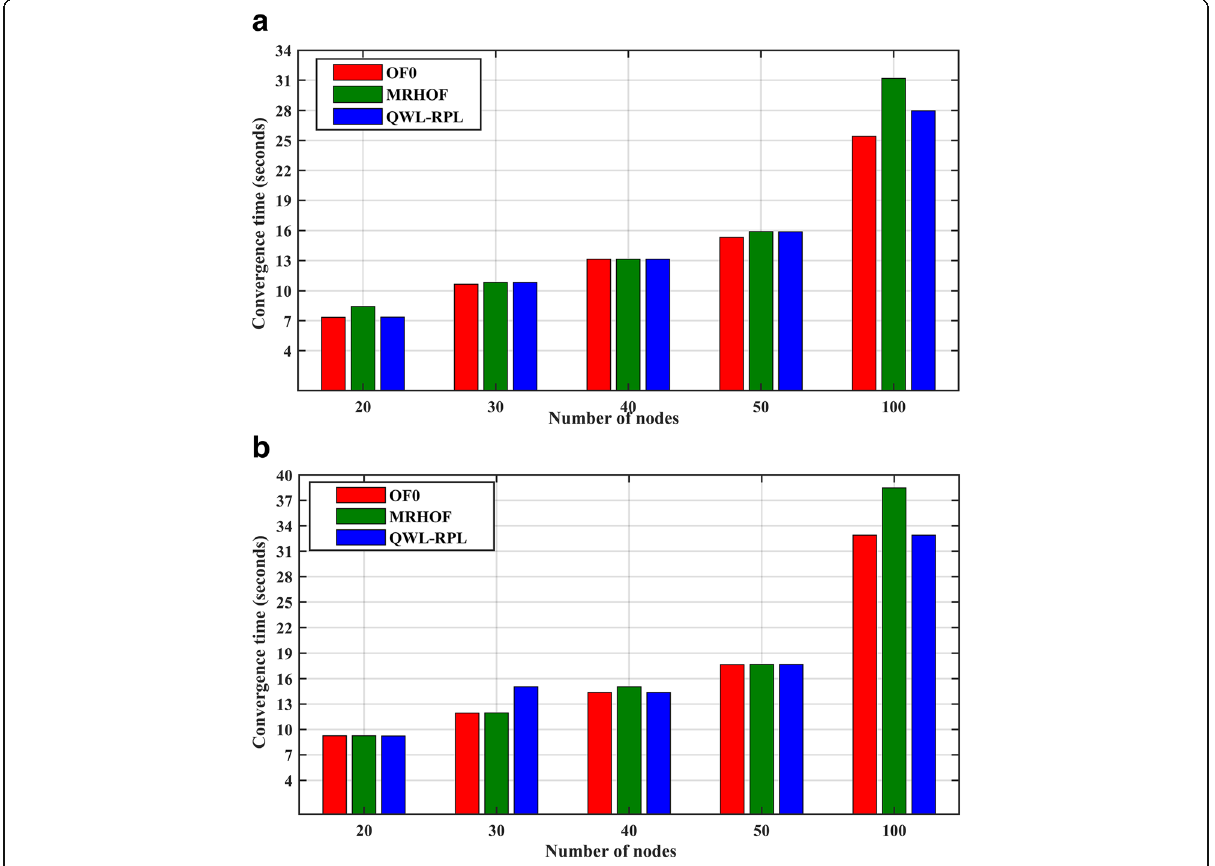
Fig. 15 Simulation analysis for the a scenario I convergence time and b scenario II convergence time versus number of